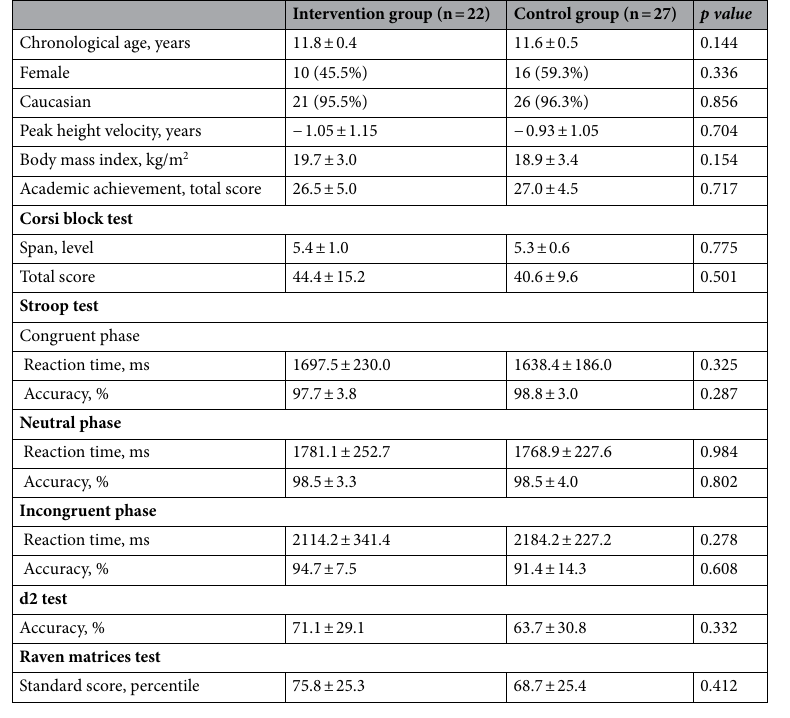
Table 1. Baseline characteristics of the